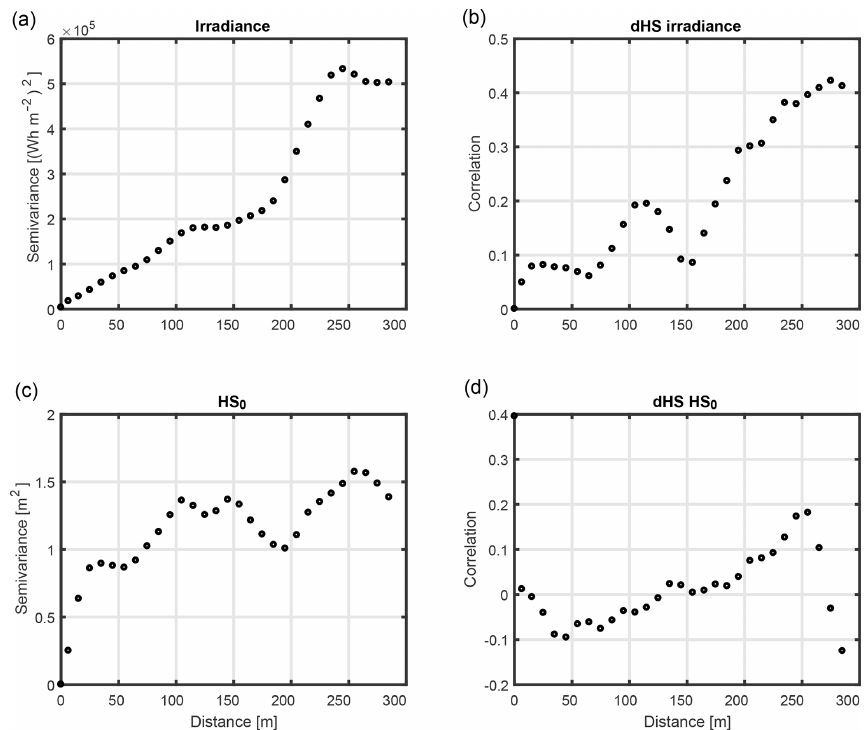
Figure 8. Correlograms of dHS with modelled irradiance and initial snow depth (HS 0 ), respectively (b, d) . Variograms for HS 0 and modelled irradiance (a, c)